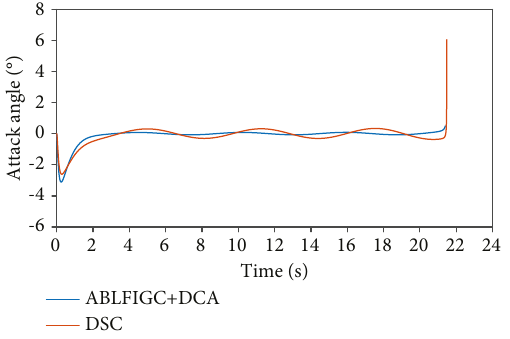
Figure 10: Attack angle curves of the interceptor missile in Scenario 2: ABLFIGC+DCA refers to a combination of the proposed asymmetric barrier Lyapunov function-based IGC algorithm and the dynamic control allocation algorithm; IGC+DCA refers to a combination of the IGC algorithm subject to the traditional dynamic surface sliding-mode control law and the dynamic control allocation algorithm.